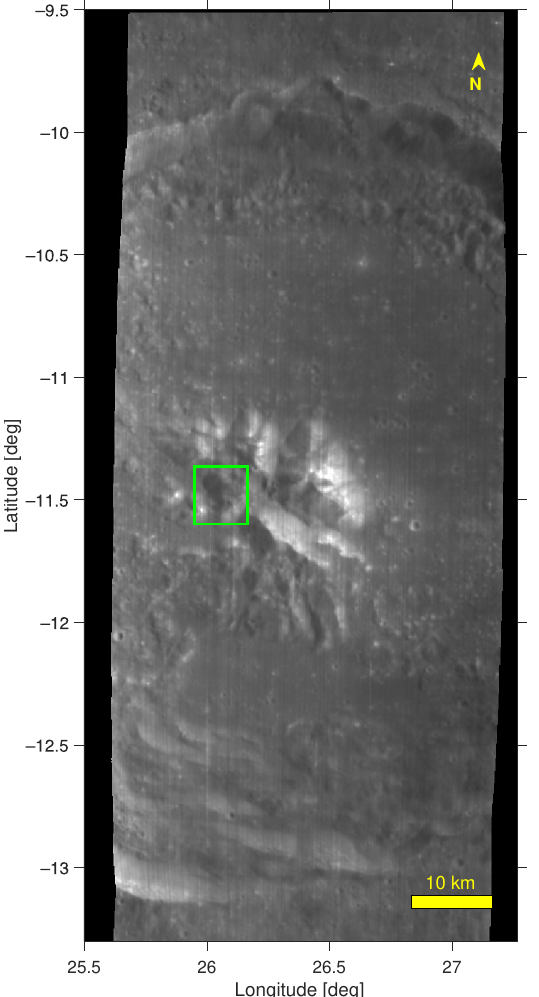
Figure 8. M 3 radiance image M3G20090203T160452 at 1.579 µ m. The region of interest at the central peak of the Theophilus crater is marked with a green